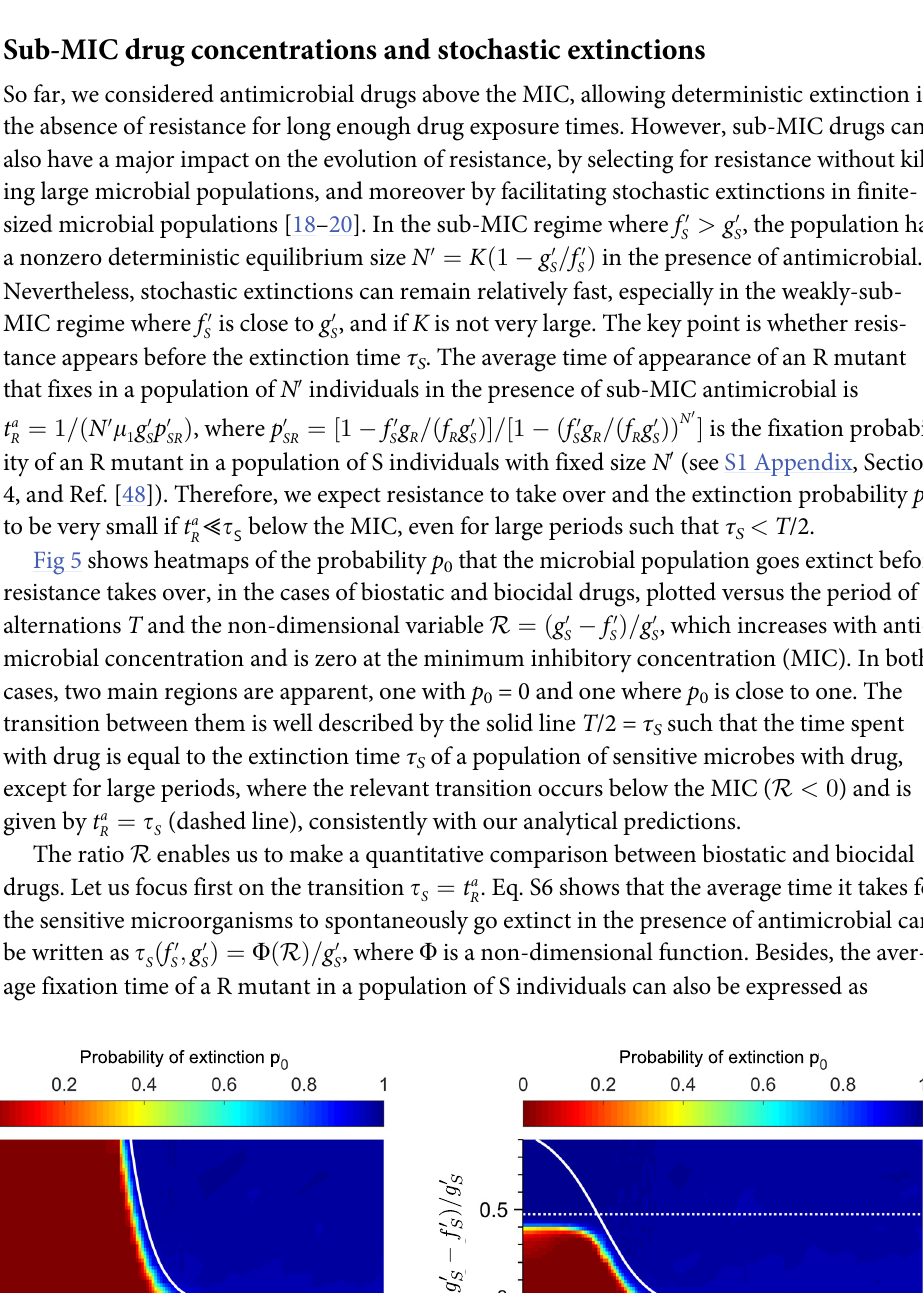
(cid:0) f 0 Þ = g 0 with S S S ¼ t (see main text). Solid white line: T /2 = τ S . S R ¼ 0 : 1 and variable f 0 or ( B ) f 0 ¼ 1 S S S (cid:0) g Þ = ð 2 f (cid:0) g Þ . All simulations start with 10 S S S S S